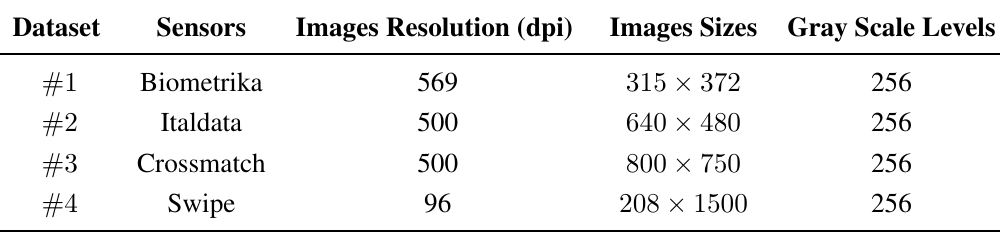
Table 1. Some characteristics of the images from the LivDet2013 datasets.